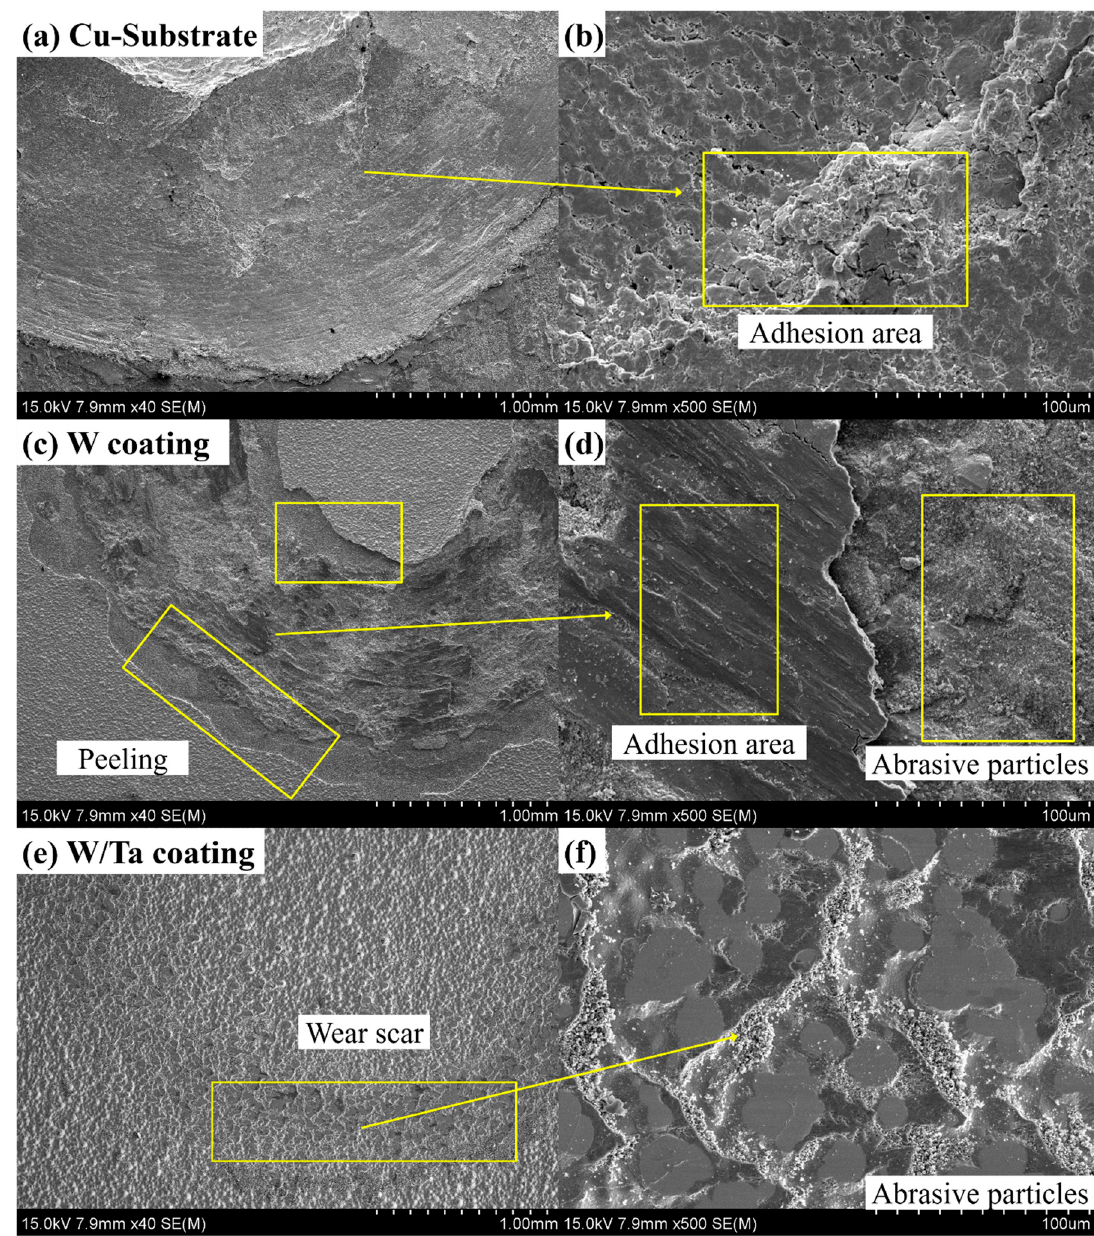
Figure 9. Morphologies of substrate and coated specimens after a tribological test at 500 °C: ( a , b ) Cu substrate, ( c , d ) W coating, and ( e , f ) W/Ta coating.